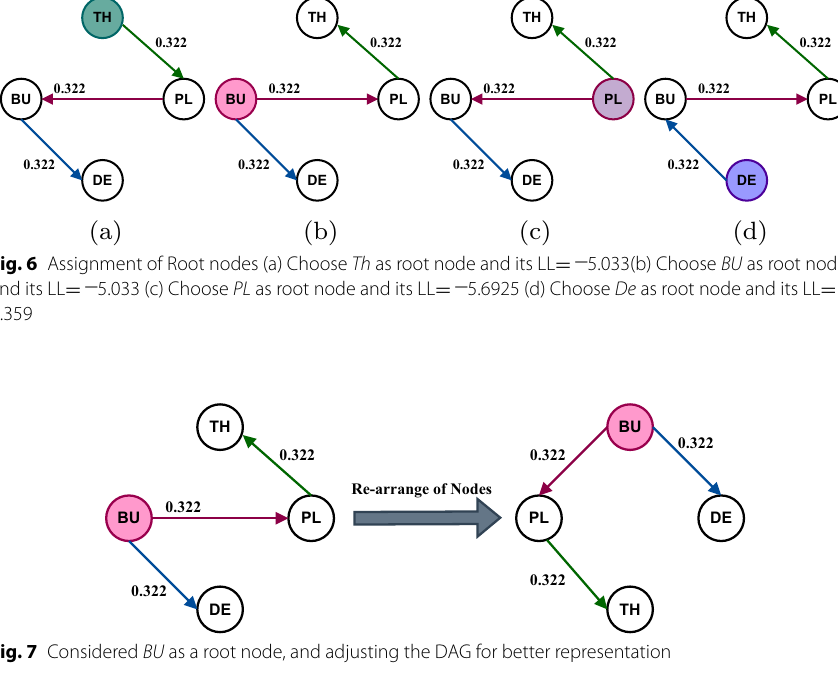
Fig. 7 Considered BU as a root node, and adjusting the DAG for better